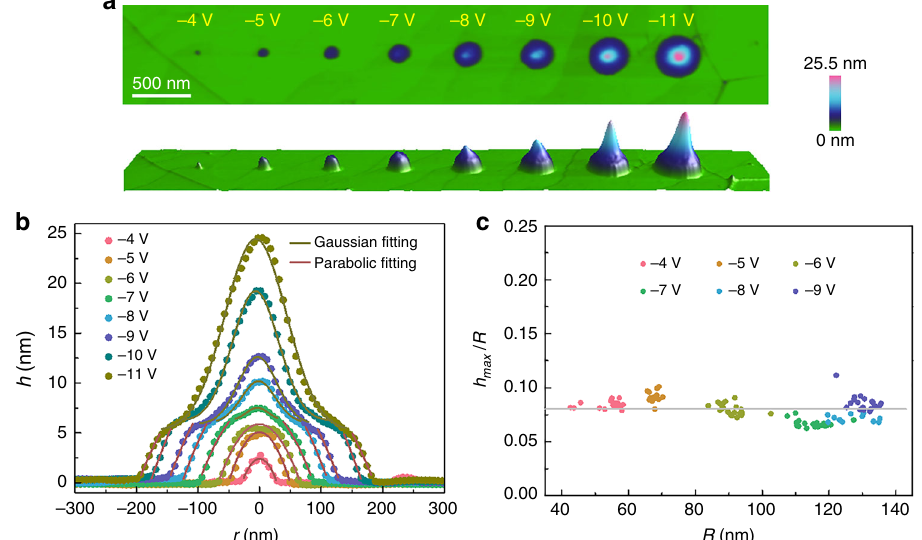
Fig. 2 The morphologies of graphene nanobubbles. a A series of GNBs created by the tip voltage varying from − 4 to − 11 V. b Line pro fi les extracted from bubbles in a with parabolic fi tting and Gaussian fi tting. c Measured aspect ratios of GNBs as a function of the base radius. The gray line shows the mean value at 0.08. Source data are provided as a Source Data fi